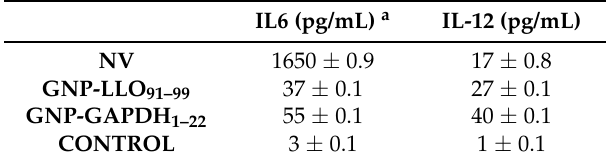
Table 3. Cytokine levels of purified microglía (MG) from P4 neonates born to vaccinated or NV mothers. IL6 (pg/mL)